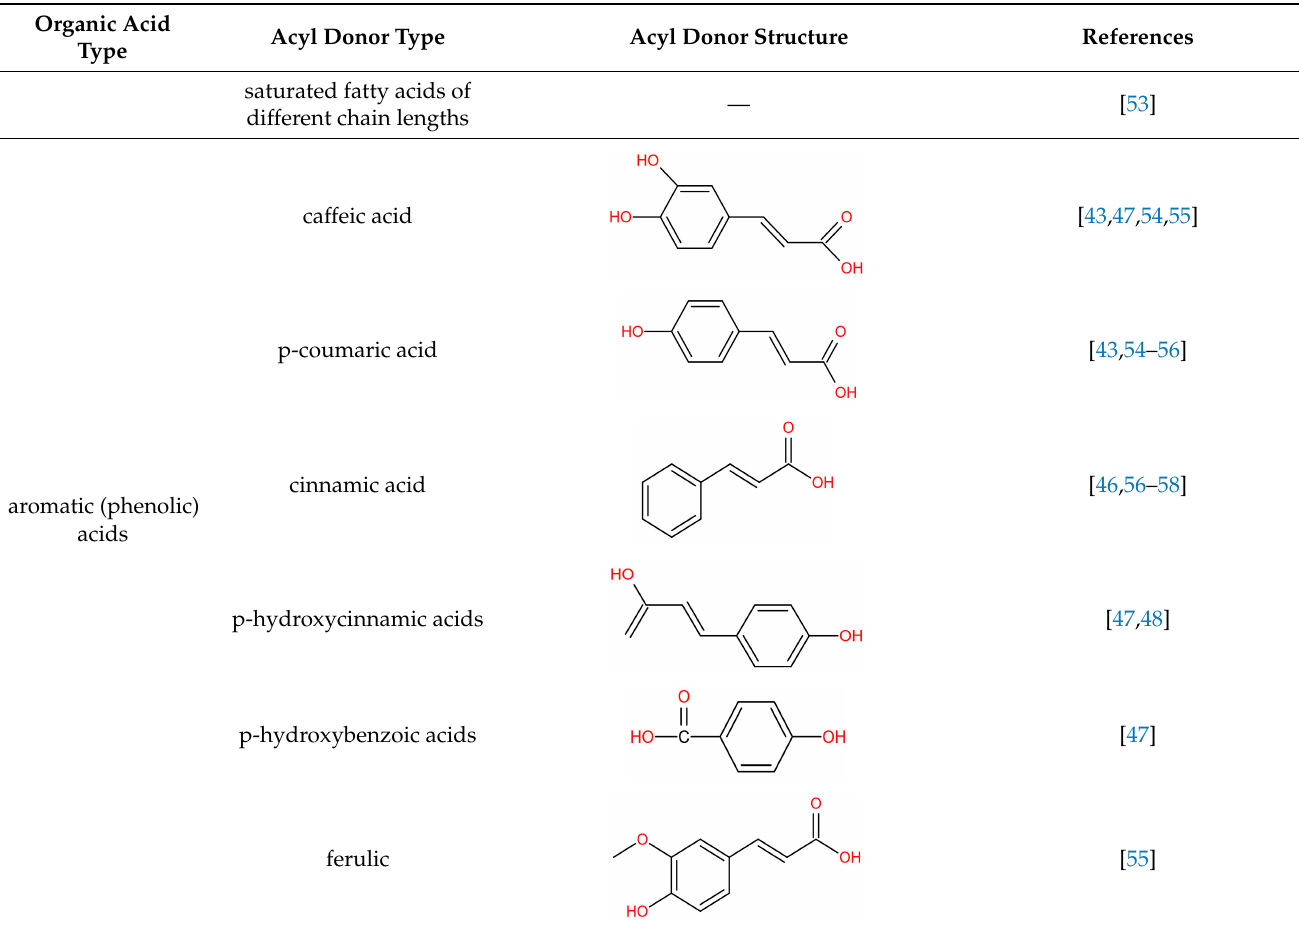
Table 2. Enzymatic acylation conditions and acylation rate of anthocyanins.